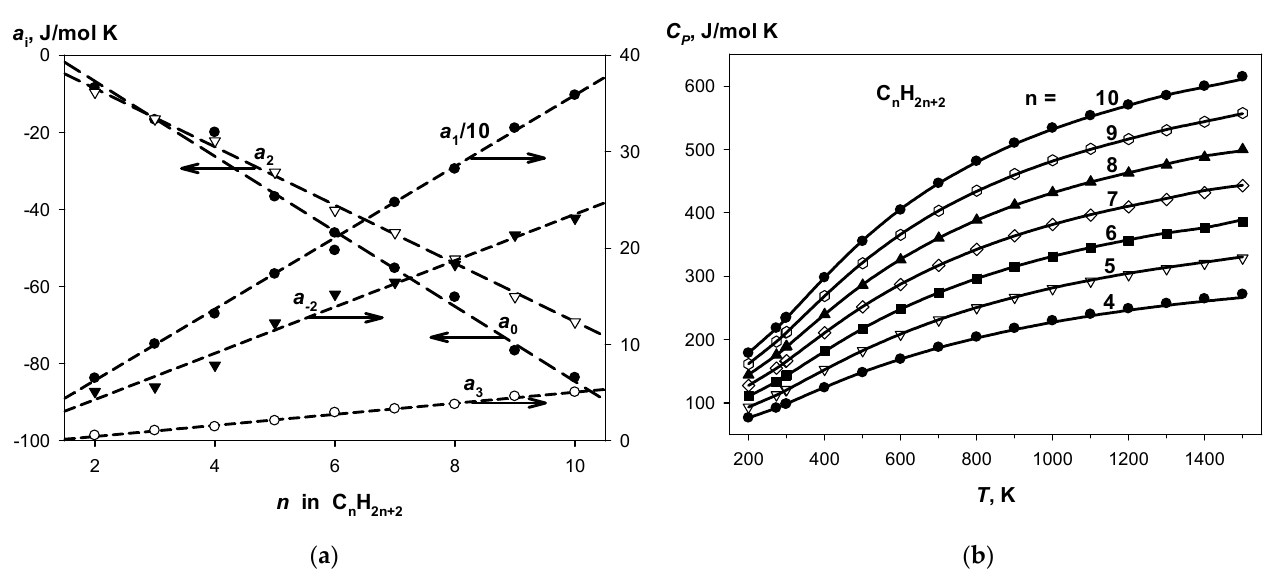
Figure 2. ( a ) Coefficients of the Shomate equation for n -alkanes. ( b ) Comparison of isobaric molar heat capacities calculated using the CS HDR3 with the recommended data. Table 6. Isobaric molar heat capacities of n -alkanes (J/mol ·